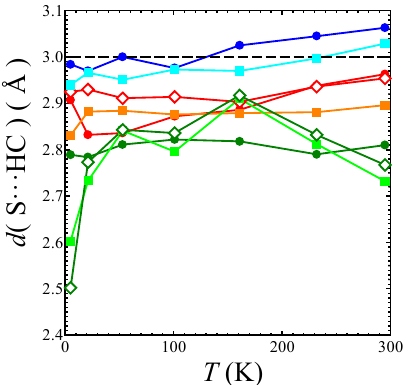
Figure 8. Temperature dependence of short S ⋯ H-C distances d (S ⋯ H-C) in the EtMe 3 Sb salt: the black dashed line shows the sum of the van der Waals radii of S atom and H atom. The red filled circles, orange filled squares, and red open diamonds mark the S ⋯ H-C 7 contacts. The blue filled circles and light blue filled squares mark the S ⋯ H-C 8 contacts. The green filled circles, spring green filled squares, and green open diamonds mark the S ⋯ H-C 9 contacts. See also Figures 1c and 9.